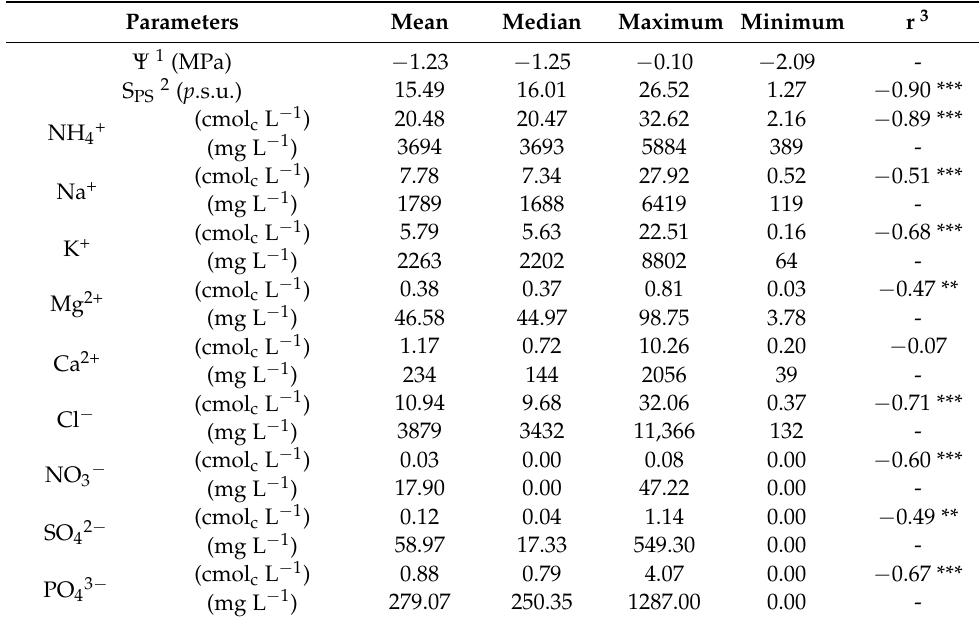
Table 5. Chemical properties of anaerobic digestates (n = 20) investigated in this study.